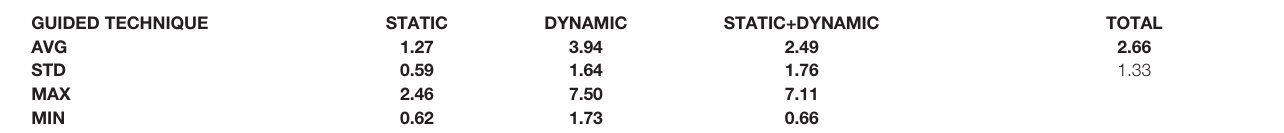
OUT*. Freehand implant placement, data excluded from